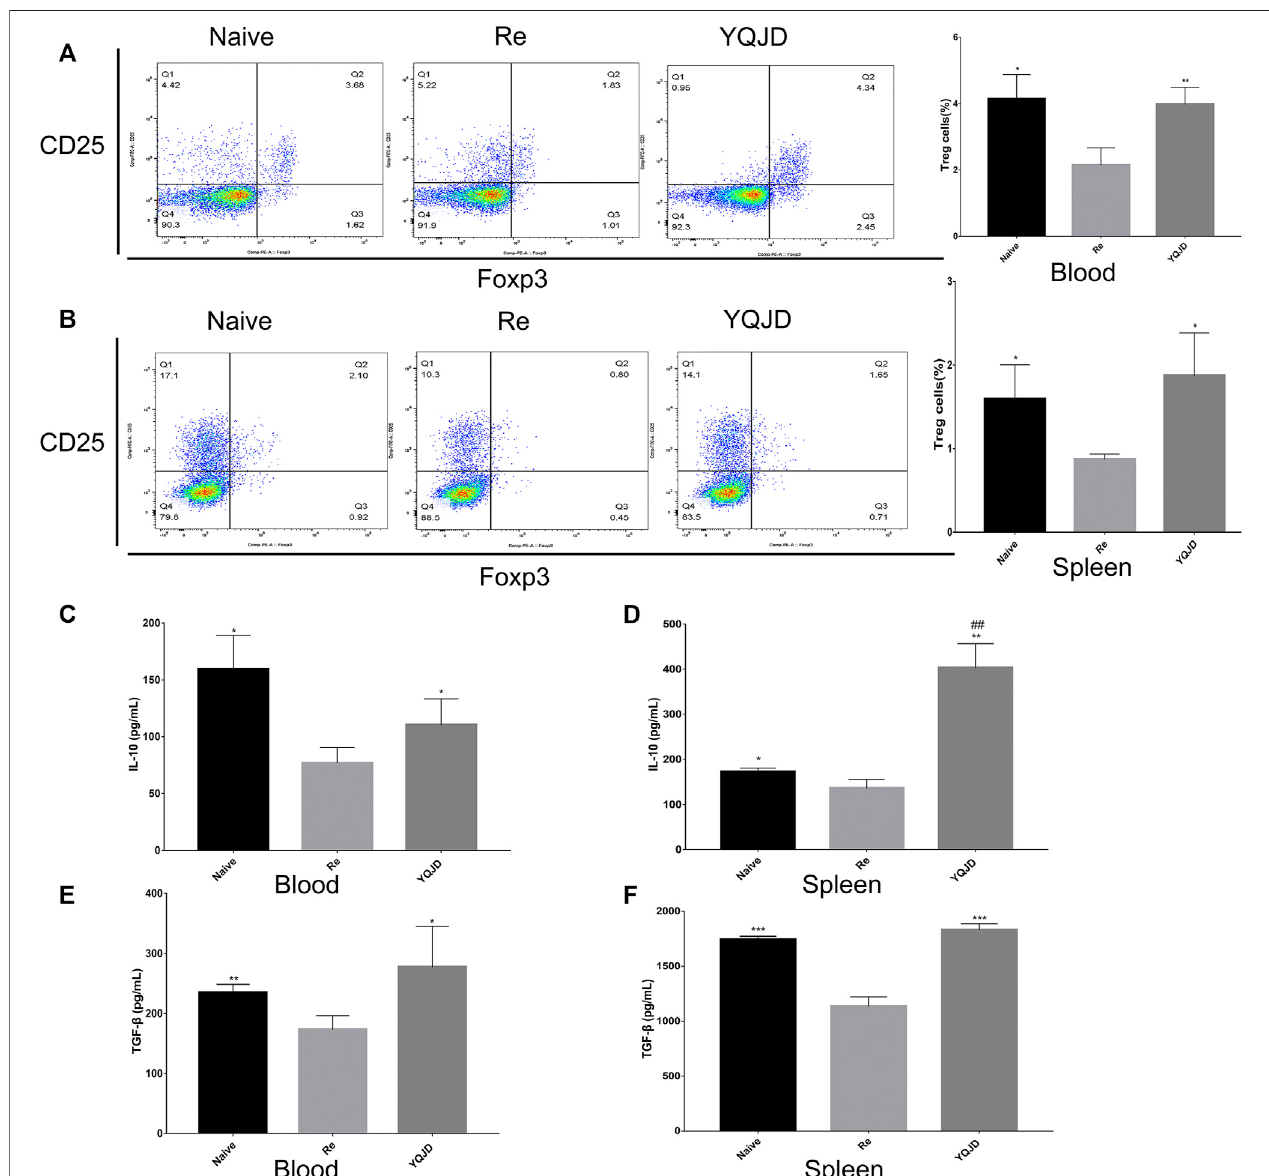
FIGURE 3 | Effects of YQJD treatment on the immune response in peripheral blood and spleen of recurrent HSK mice. (A) Levels of CD4 + CD25 + Foxp3 + Tregs in peripheralblood. (B) LevelsofCD4 + CD25 + Foxp3 + Tregsinthespleen. (C) ExpressionofIL-10inperipheralblood. (D) ExpressionofIL-10inspleencells. (E) Expression of TGF- β in peripheral blood. (F) Expression of TGF- β in spleen cells. The data are expressed as the mean ± SD of fi ve independent experiments. *p < 0.05, **p < 0.01, and ***p < 0.001 vs. the Re group; #p < 0.05 and ##p < 0.01 vs . the Naive group.